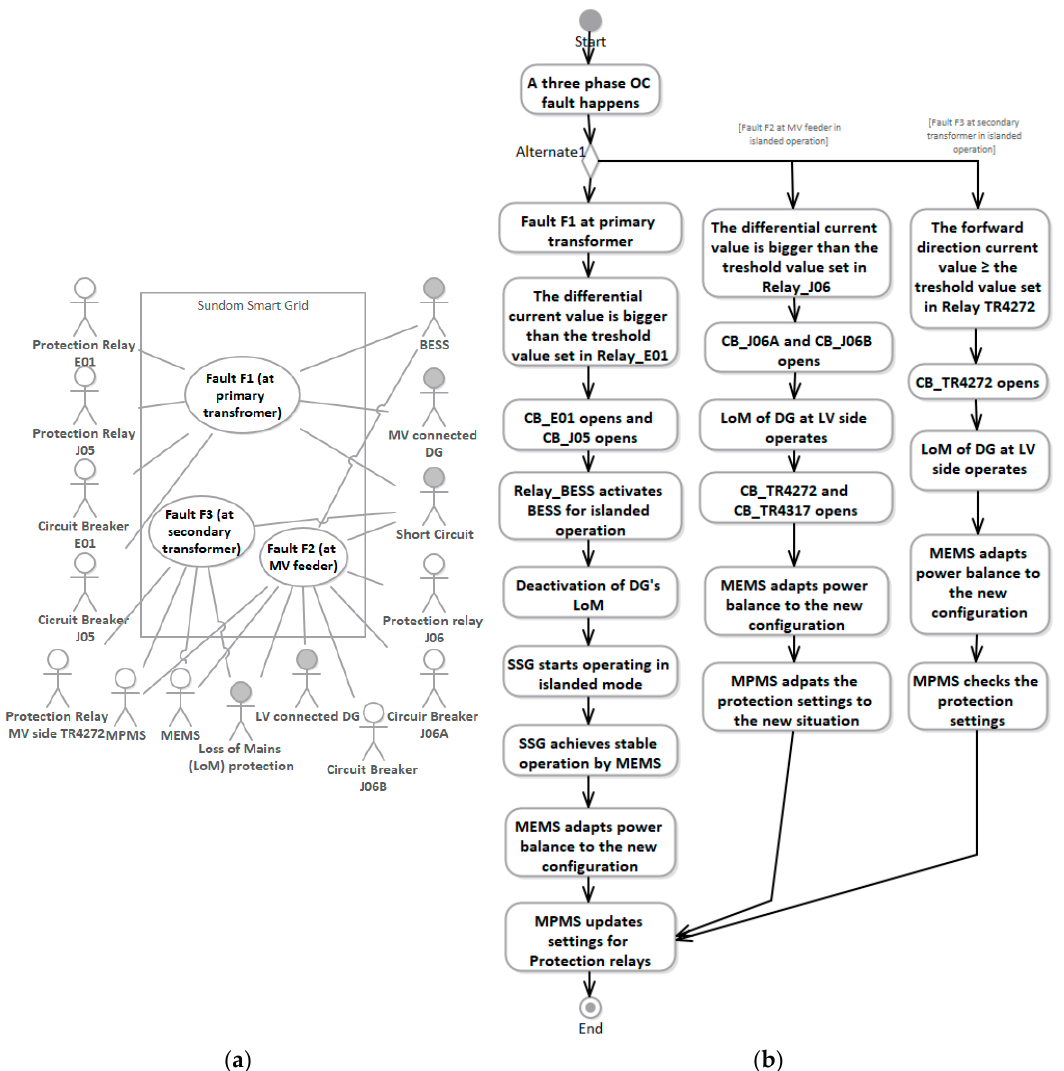
Figure 11. The protection PUC for the Sundom Smart Grid: ( a ) use case diagram; ( b ) activity diagram.